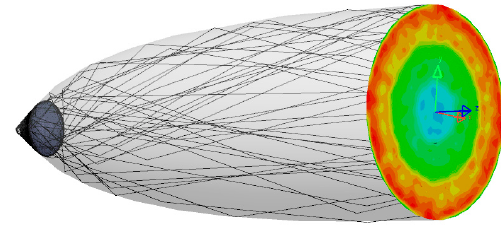
Figure 16. LENS Pixel ray trace with Illuminance pattern output obtained with LightTools software.